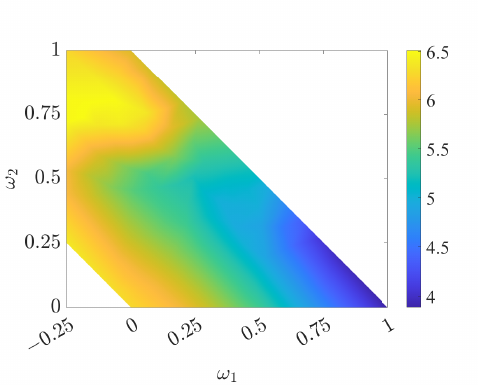
Figure 9. Distribution of the lift-to-drag ratio in the design space.